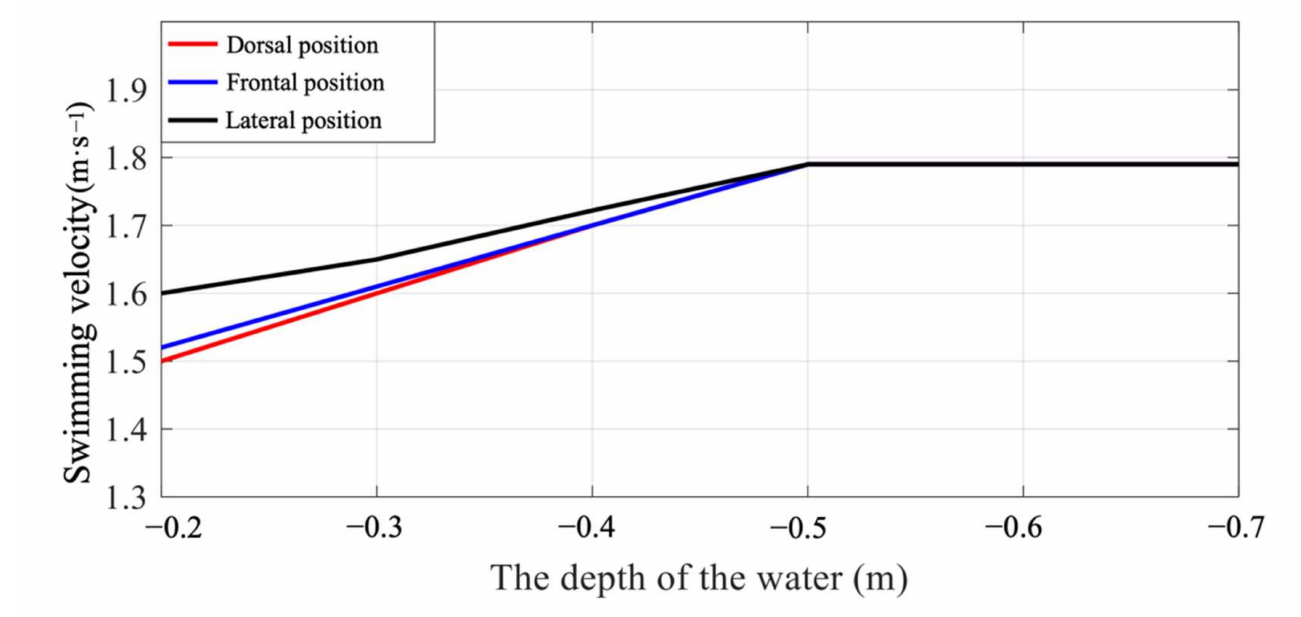
Figure 9. The swimming velocity of the three swimming positions at different water